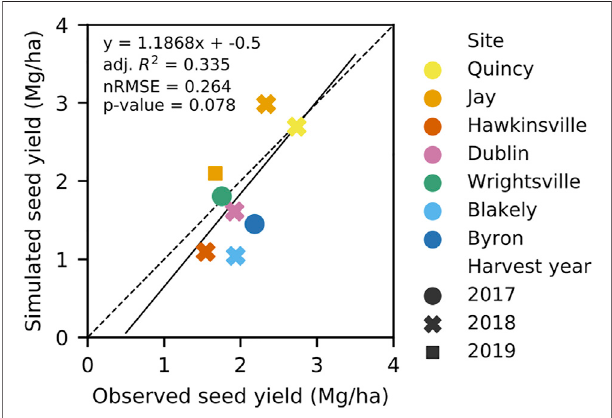
FIGURE 2 | DayCent model validation results, using fi eld observations described in Table 1 .